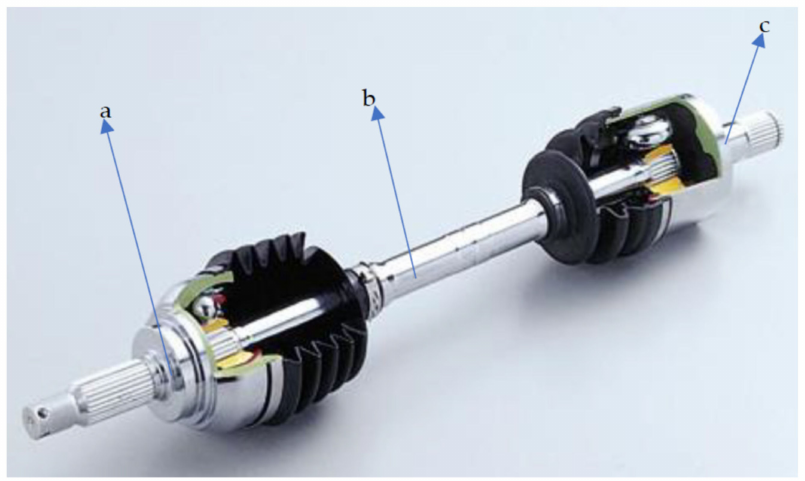
Figure 2. The details of an AD.